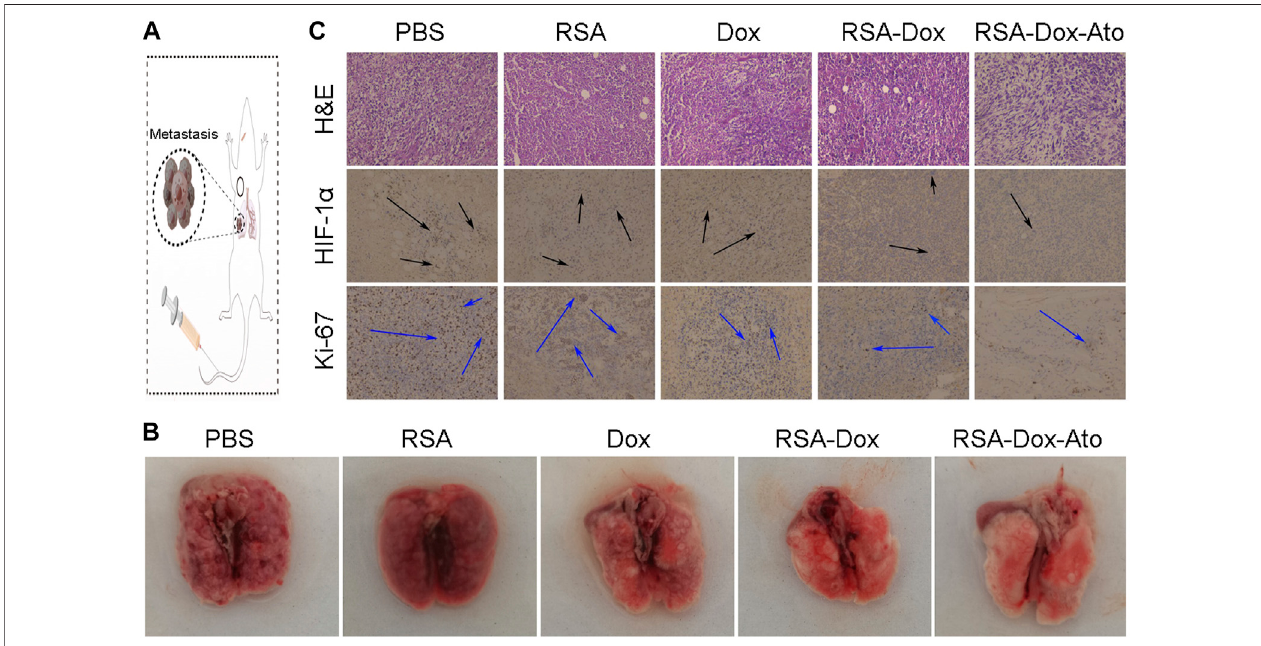
FIGURE 5 | The pathological analysis and lung metastasis of mice received RSA-Dox- Ato NPs with the intravenous injection ( n = 3). (A) Scheme of RSA-Dox-Ato NPs against tumors. (B) Representative images of tumor metastasis were collected from mice after treatments with RSA-Dox-Ato NPs. (C) The pathological sections were analyzed by unitizing H &E staining, HIF-1 α , and Ki-67 (×10 objective).